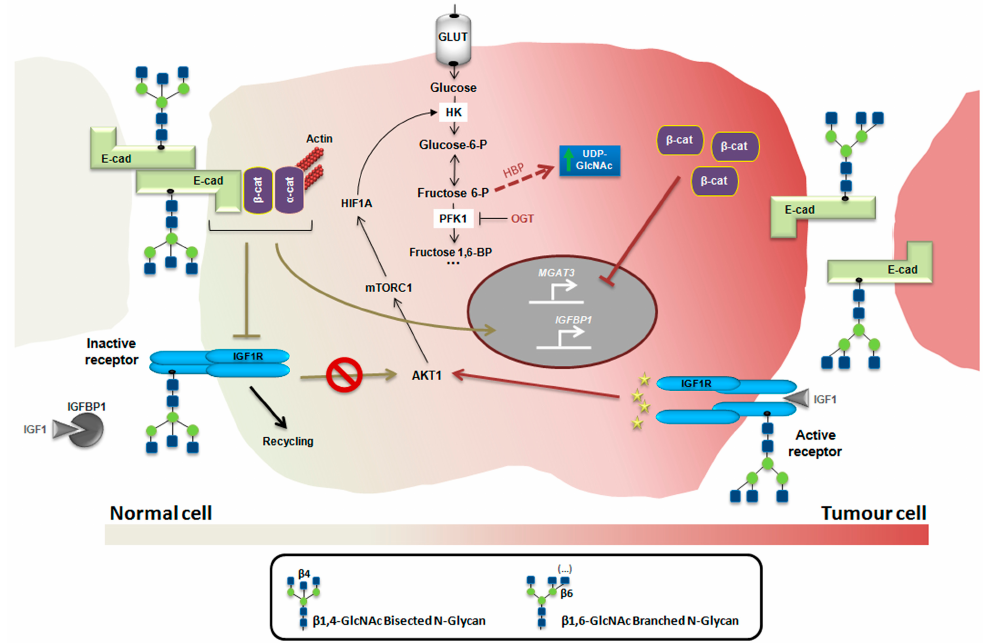
Figure 2. Glycans and insulin/IGF system in cancer: an integrated mechanism. In a normal context, high levels of bisecting GlcNAc N -glycans catalyzed by GnT-III favor the establishment of a stable phenotype through E-cadherin-mediated cell-cell adhesion, which in turn promotes MGAT3 expression establishing thereby a functional feedback loop. Both the stable adherens junctions and IGFBP1 expression lead to the inhibition of IGF1R activity, which were associated with a decrease of the AKT1/mTORC1/HIF1A/HK axis. In a cancer context, the high levels of β 1,6-branched N -glycans, catalyzed by GnT-V enzyme destabilizes E-cadherin-mediated cell-cell adhesion and favors the activation of IGF1R-mediated signaling thus increasing the AKT1/mTORC1/HIF1A/HK axis. Furthermore, as a consequence of the high HK activity, the hexosamine biosynthetic pathway (HBP) flux become higher, increasing the GlcNAc biosynthesis and the branched N -glycosylation. In addition, the translocation of cytoplasmic β -catenin to nucleus promotes inhibition of MGAT3 expression, that concomitantly with the repression of IGFBP1 results in a positive feedback mechanism on IGFR1 activity. OGT, O -linked N -acetylglucosamine transferase. GnT-III catalyzes the bisecting GlcNAc N-glycan structure and GnT-V catalyzes the β 1,6 GlcNAc branched N -glycans.